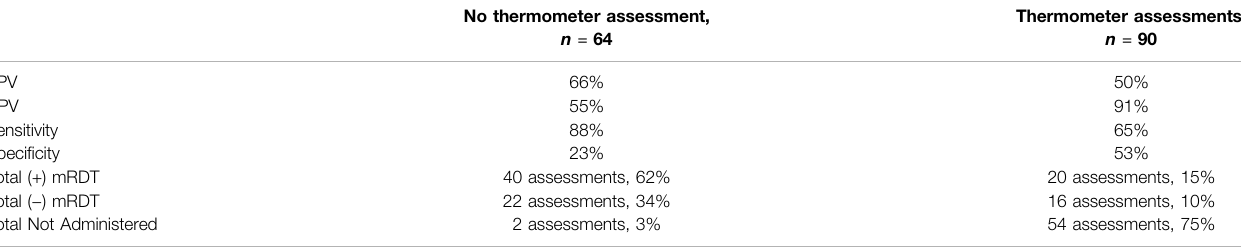
TABLE 8 | Comparison of THINKMD predictive statistics for a Community Health Worker (CHW) with dominant use and a CHW with low use of a